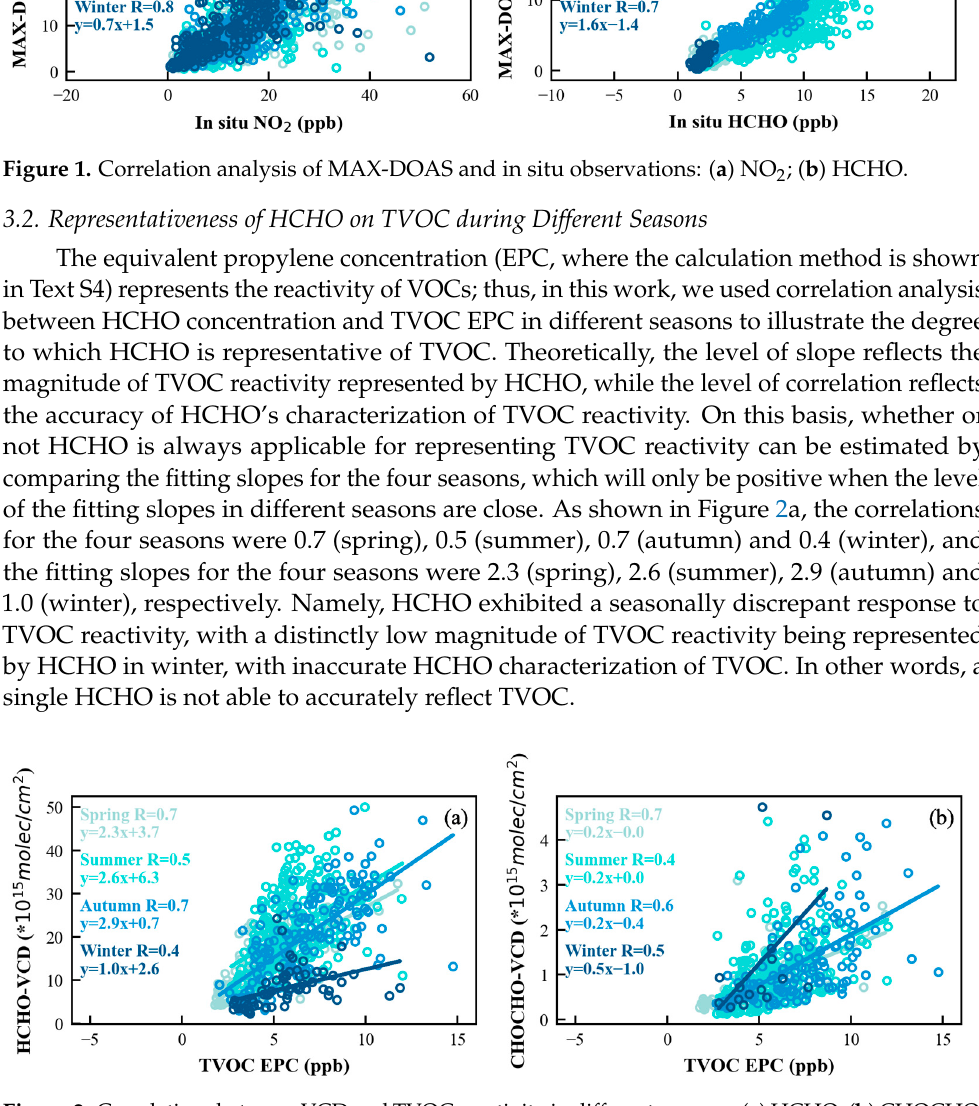
Figure 2. Correlations between VCD and TVOC reactivity in di ff erent seasons: ( a ) HCHO; ( b )